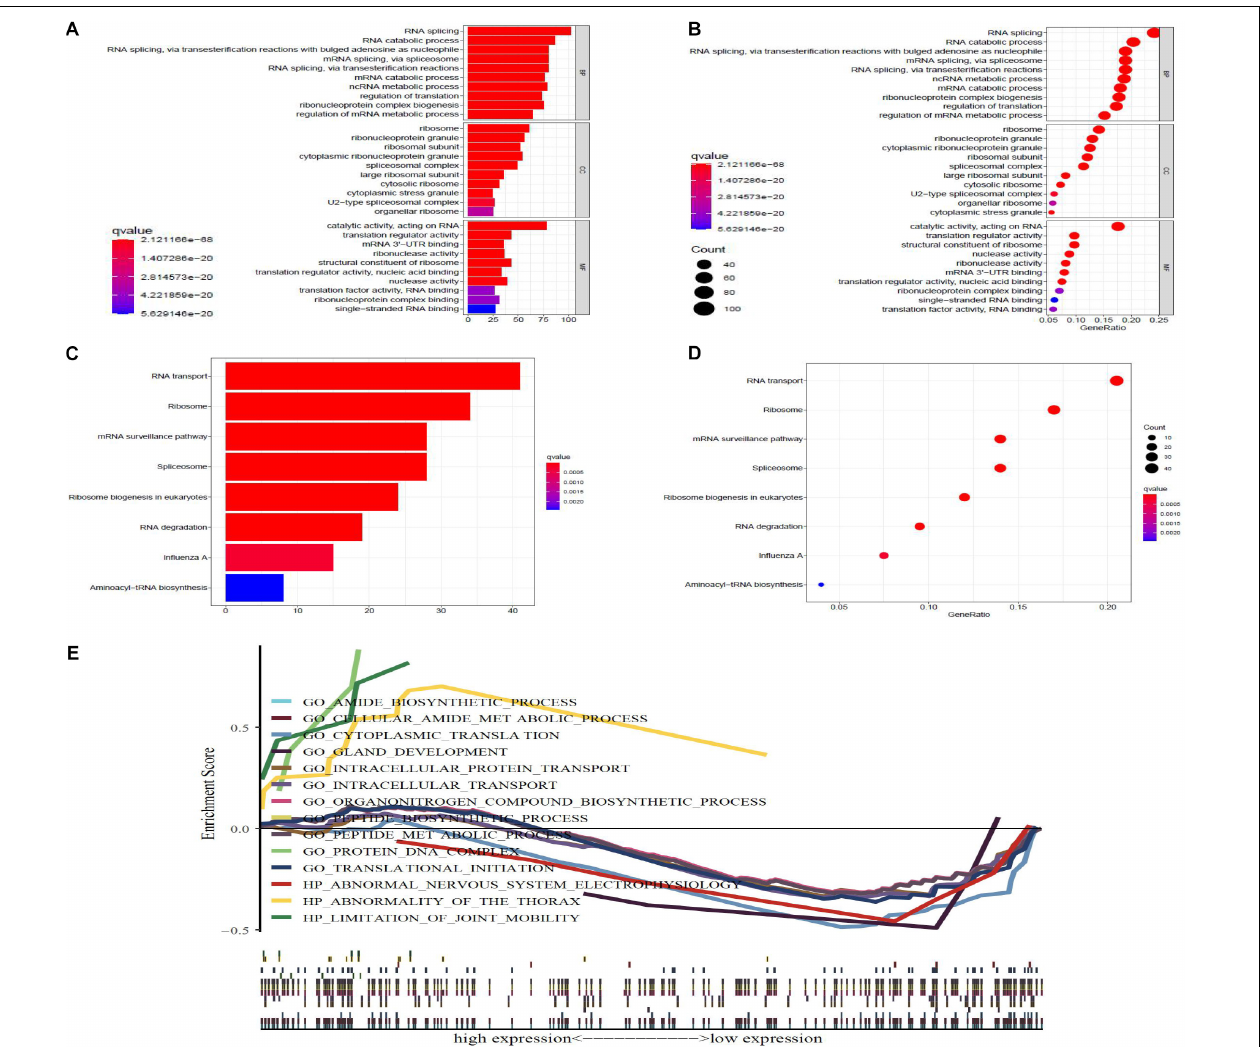
FIGURE 3 | GO, KEGG, and gene set enrichment analysis (GSEA), enrichment analysis of differential expression-RBPs (DE-RBPs) in PAAD. Panels (A,B) are barplot and bubble plot, respectively, of GO functional enrichment analysis; BP, biological process; CC, cellular component; MF, molecular function. Panels (B,D) are barplot and bubble plot, respectively, of KEGG pathway enrichment analysis. P -value < 0.05 and q -value < 0.05 are considered statistically significant. (E) GSEA analysis for DE-RBPs. P -value < 0.05 and normalized enrichment score | NES| > 1 were considered statistically